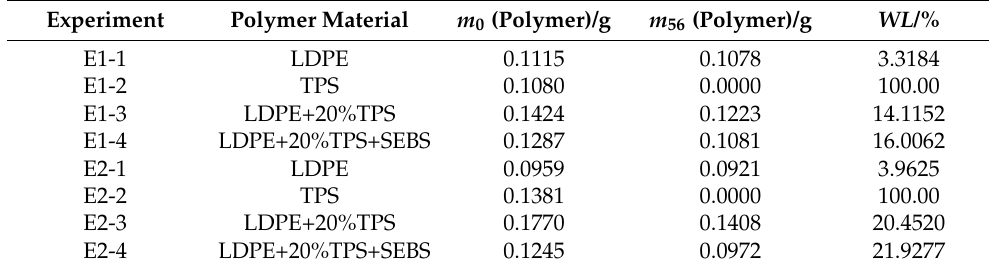
Figure 6. Change of dissolved oxygen concentration in experiments ( a ) E1 and ( b ) E2 during 56 days of biodegradation experiments. Table 5. Weight loss of polymer materials after screening test.